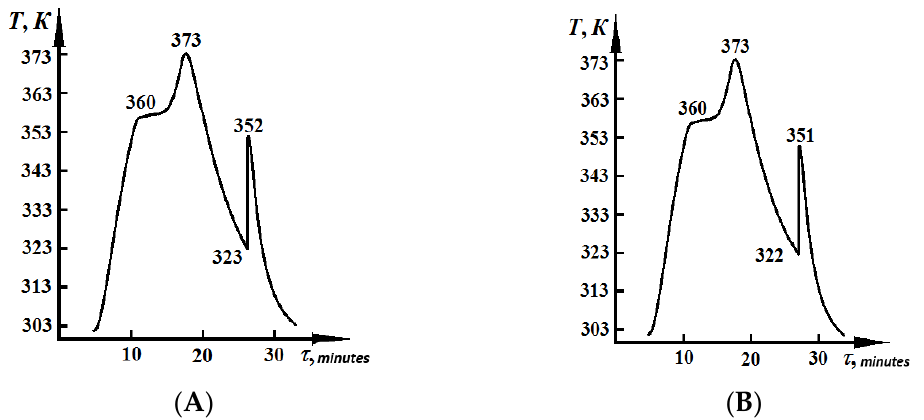
Figure 5. Experimental thermograms for heating and cooling of m-terphenyl of analytical grade ( A ) and preliminarily purified m-terphenyl ( B ). ( A ) and preliminarily purified m-terphenyl ( B